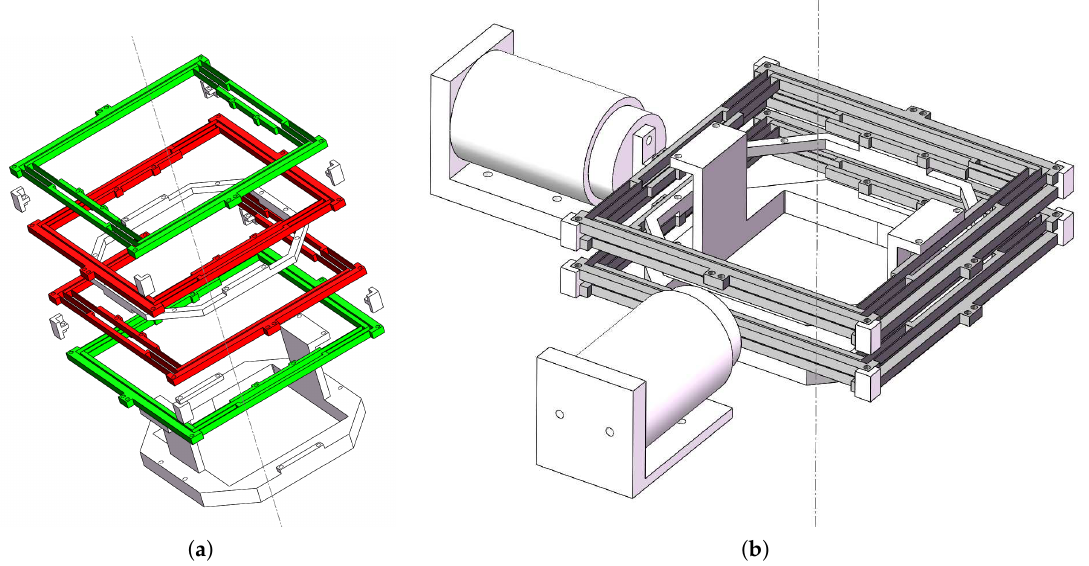
Figure 5. Illustrations of ( a ) explosive view and ( b ) CAD model of the assembled xy